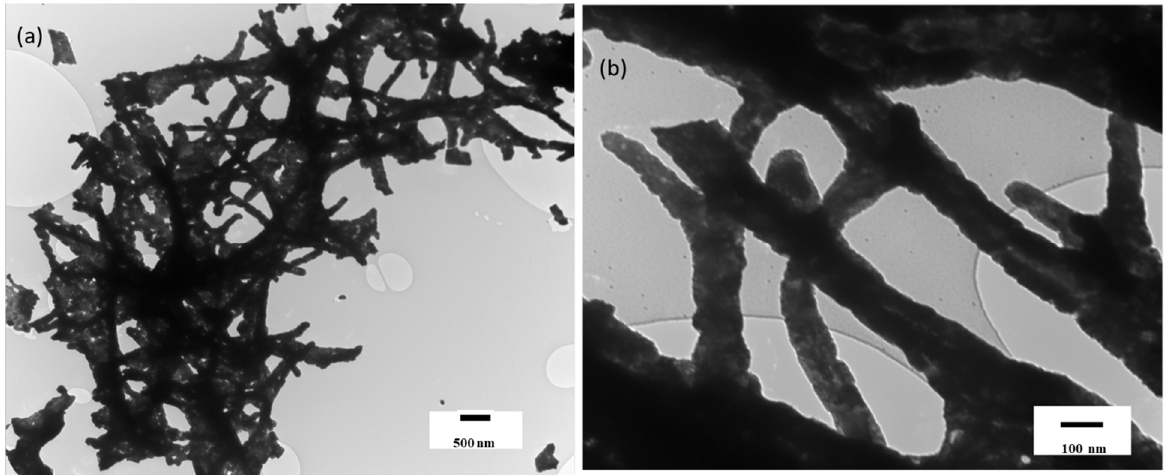
Figure 2. TEM images of Cobalt oxide nanowires at different magnifications, ( a ) low, and ( b ) high. A histogram diagram which is presented in Figure 3 was plotted to present the average diameter (nm) of Co 3 O 4 nanostructures. The average diameter calculated from the histogram was 149 ± 34 nm (Figure 3).